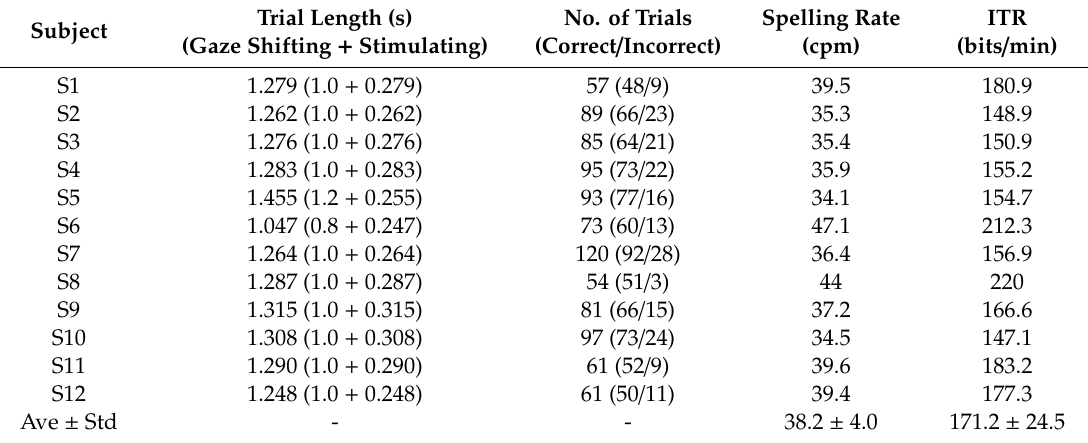
Table 2. Performance of online free spelling